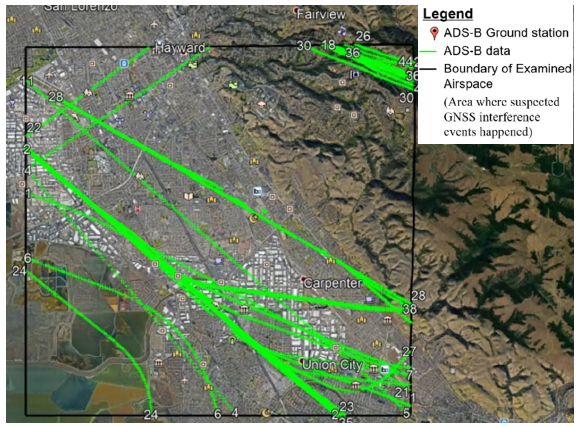
Figure 2. Top view of ADS-B data at KHWD